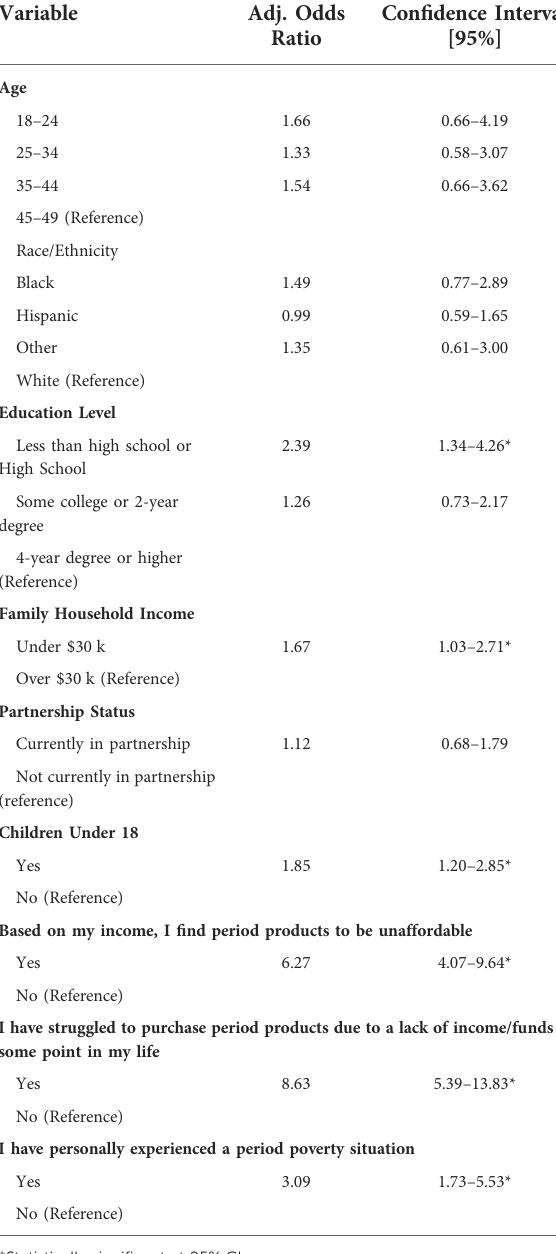
TABLE 4 Weighted logistic regression for predictors of struggling to purchase period products in the past year due to the COVID-19 pandemic ( n